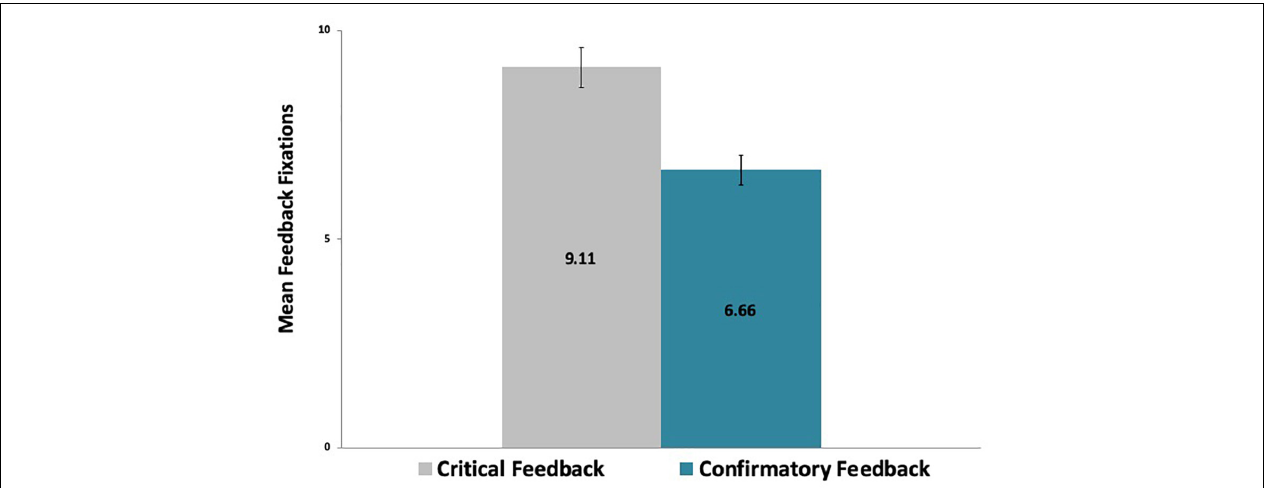
FIGURE 6 | Participants’ fixations on critical feedback messages were significantly more numerous than on confirmatory feedback messages across the game.